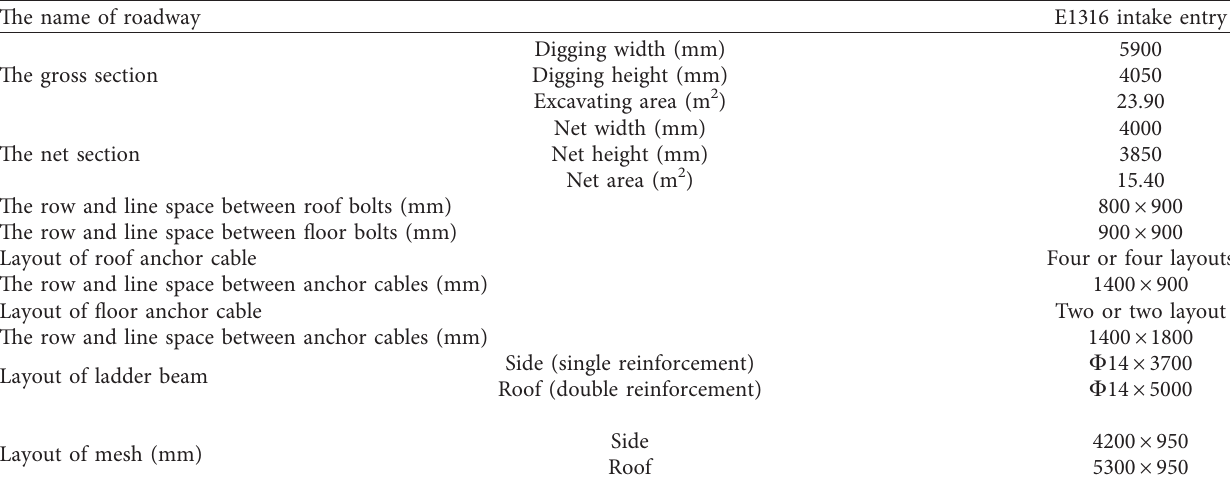
Table 2: Roadway support parameters.